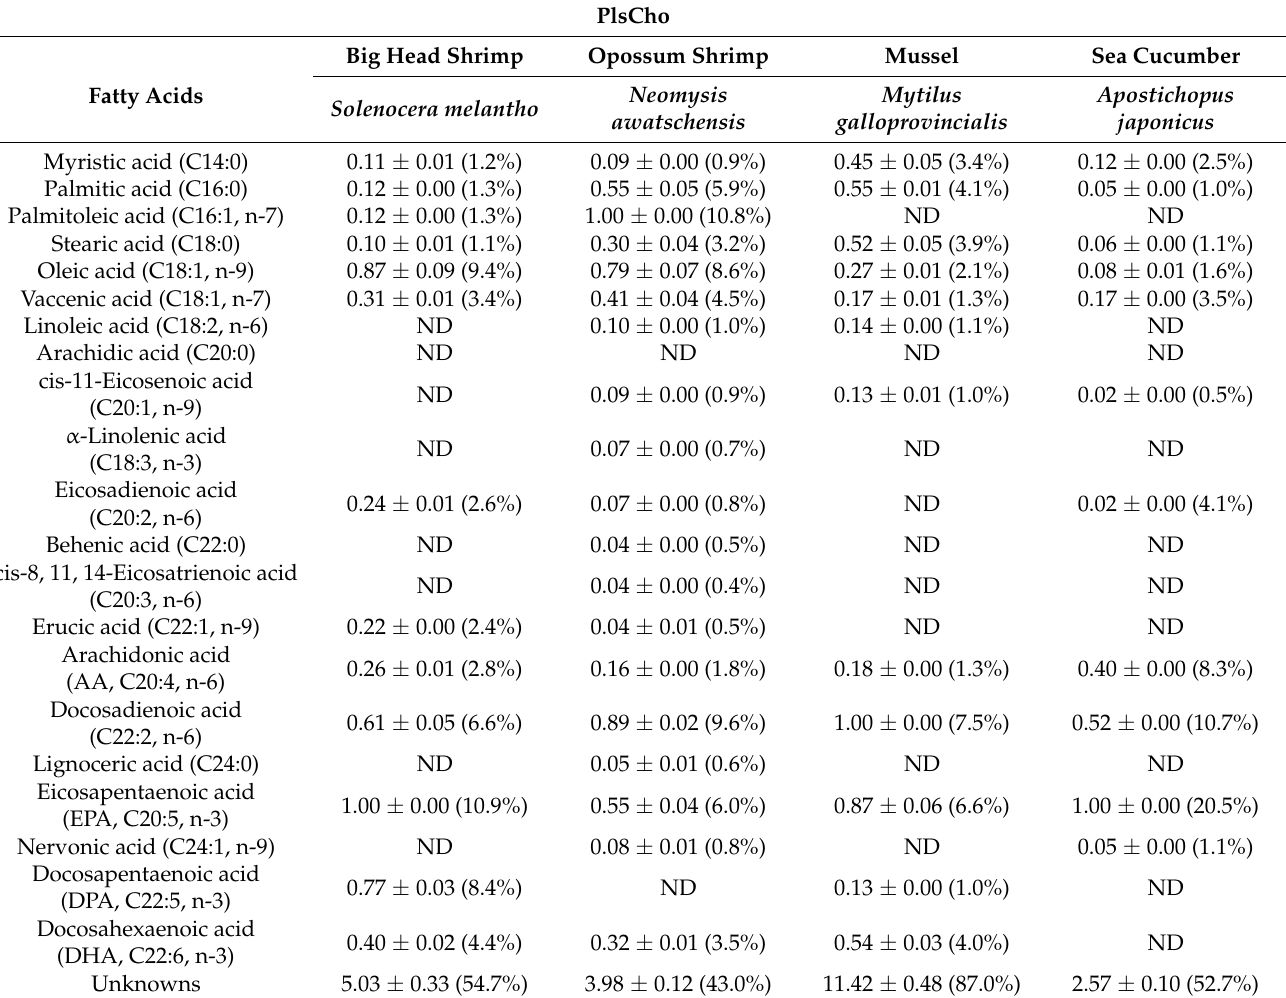
Table 3. Fatty acid composition (area %) and relative index of plasmalogen in the extracted lipids from the dried big head shrimp, opossum shrimp, mussel, and sea cucumber. Relative index = value of each fatty acid area/value of the largest known fatty acid